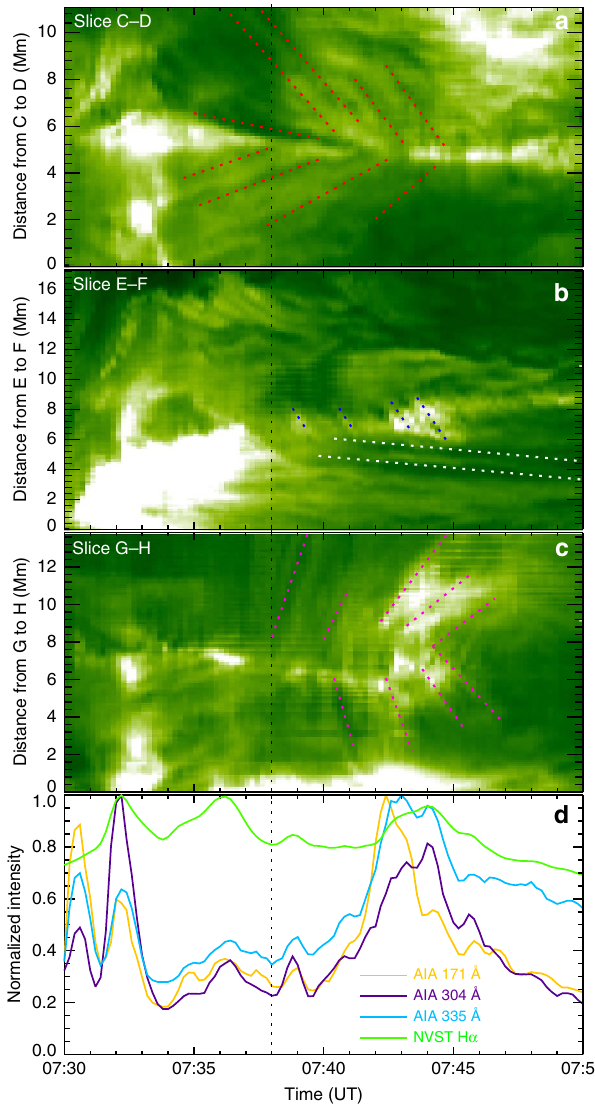
Figure 4 | Time-slice plots and EUV brightening. ( a – c ) H-alpha time-slice plots made by stacking the slits along the slices C–D, E–F and G–H in Fig. 2, respectively. The red-, blue-, white- and pink-dotted lines represent reconnection inflows, outflows, shrinking loops, and downward motions, respectively. ( d ) Temporal evolution of the brightenings in the region marked by the black circle in Fig. 2g, using H-alpha, 304, 171 and 335Å images, where each light curve is normalized by its maximum. The vertical black-dotted line in each panel indicates the onset of the observed fast reconnection.